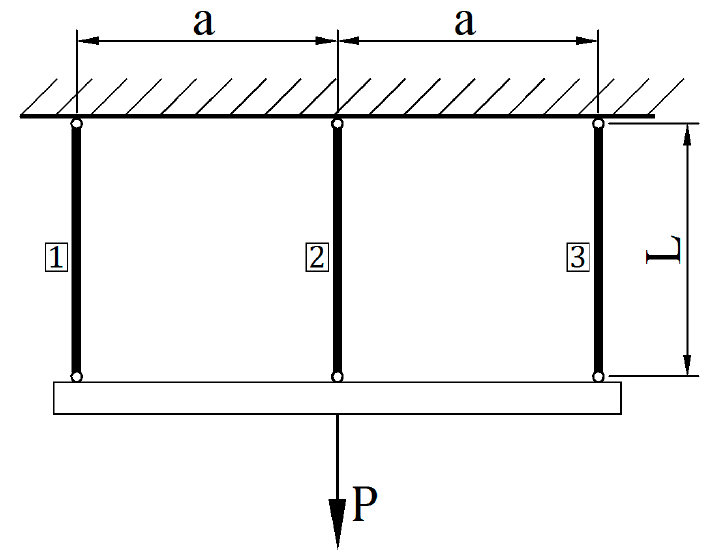
Figure 14. A three bar system in tension. The bars have the same length L and the distances between them are constant and are indicated as a. It is assumed that the upper fastening position of each bar (marked with numbers as i = 1, 2 and 3) are not displaced in any way. At the bottom, the bars are attached to a beam, which was treated as a rigid body. The tensile force P is transmitted to the system through the beam. Individual bars have different cross-section areas A i and can also be made of materials that feature different properties. Tensile forces inside the bars are indicated as P . (cid:2919) The system being solved is statically indeterminable. Three equations have been for- mulated to solve the problem: two static equations and one displacement-related equa- tion, resulting from the assumption that the beam is a rigid body (no deformations). The sum of forces equation of the analyzed case is as follows: